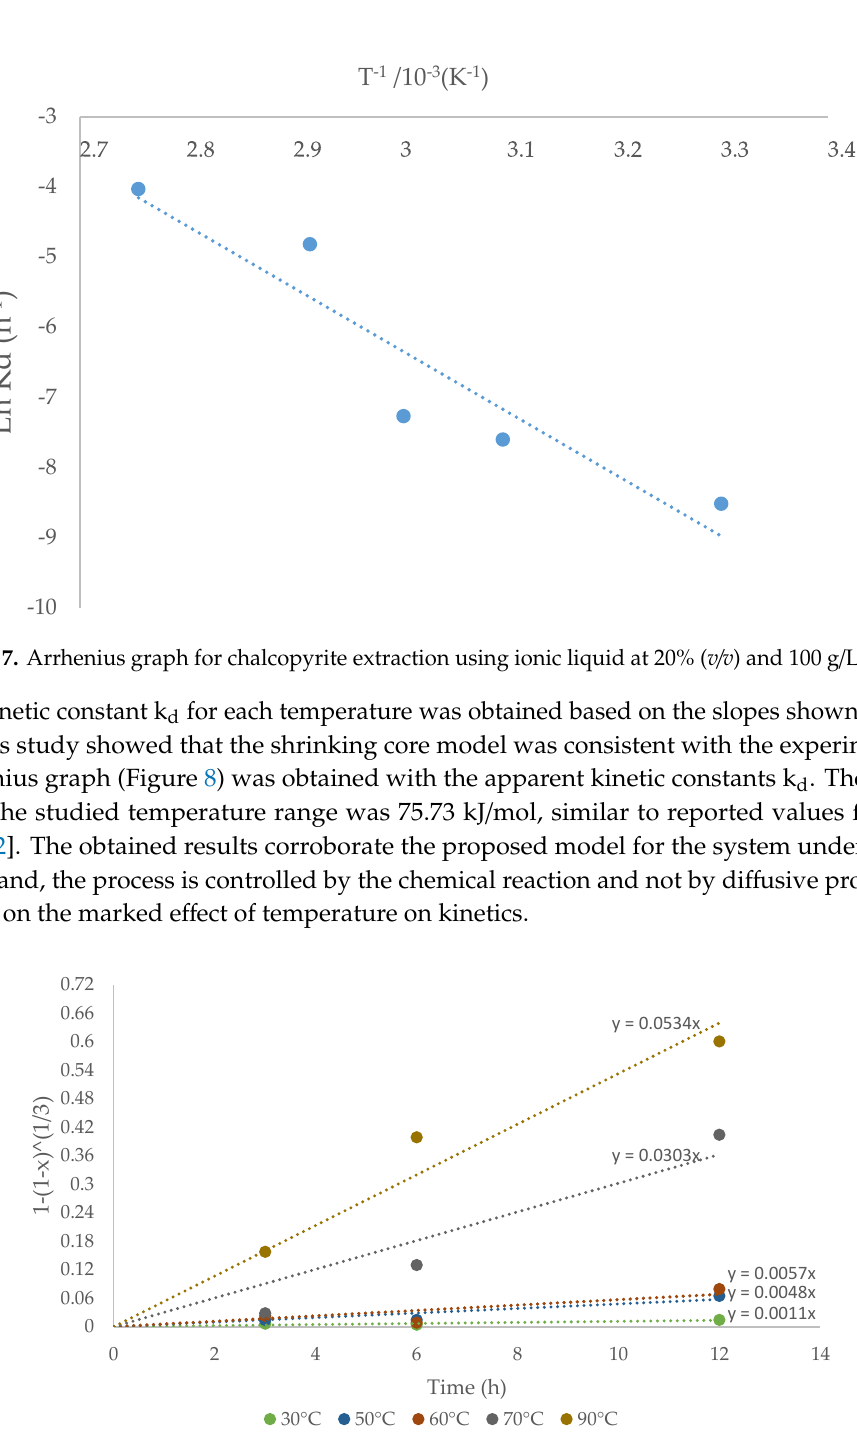
Figure 8. Plot of 1 − (1 − x ) 1 / 3 versus CuFeS 2 dissolution time.